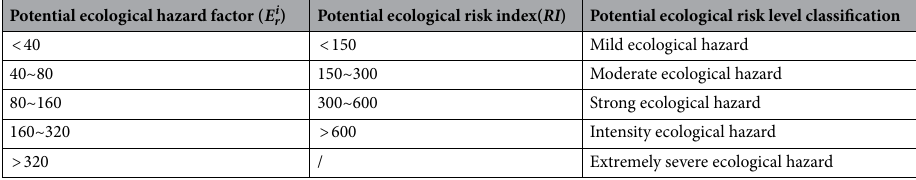
Table 2. Classification of potential ecological risk factor.